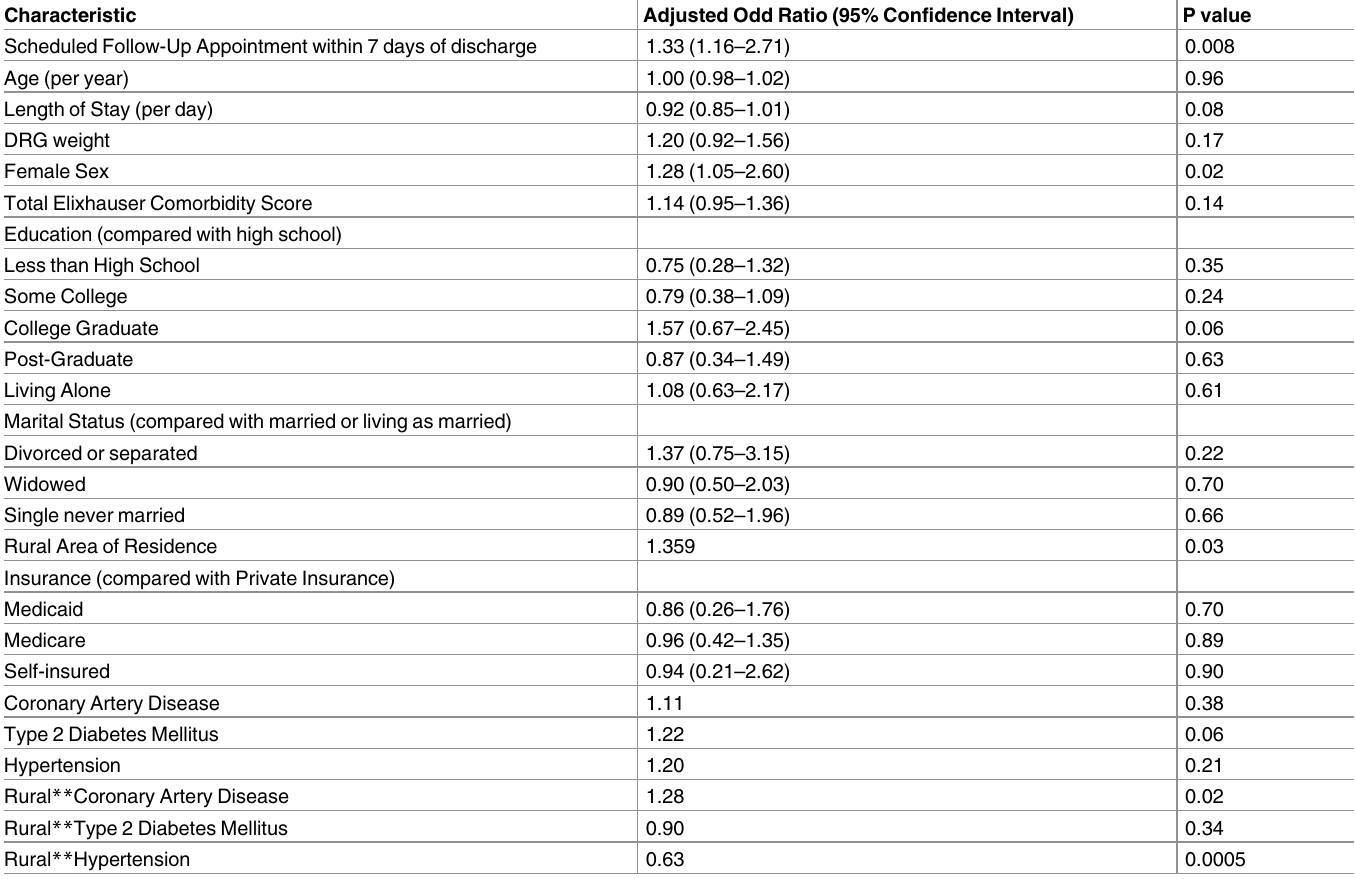
Table 3. Adjusted effect of early planned follow-up and post-discharge adverseevents. (N = 545) * .